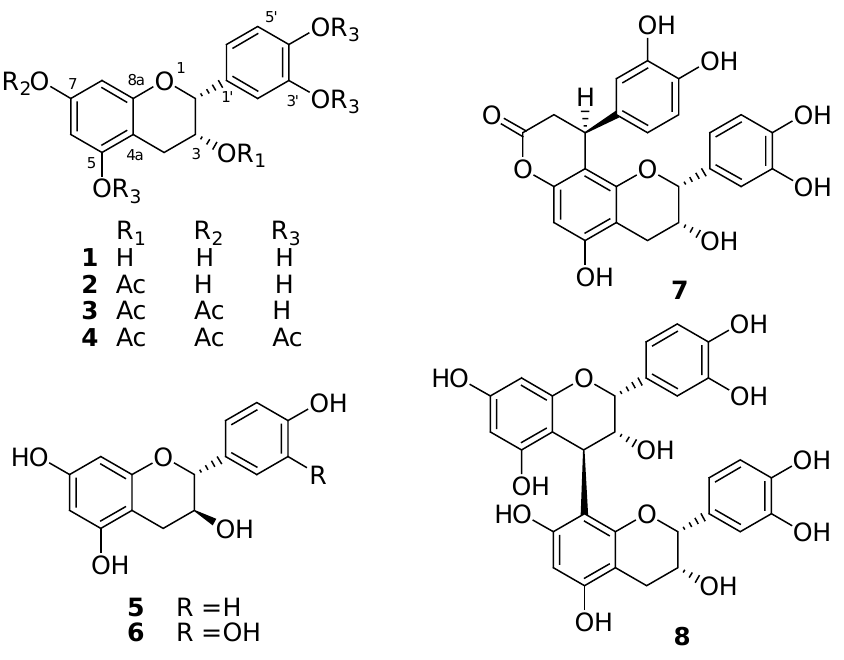
Figure 2. The chemical structure of compounds 1 - 8